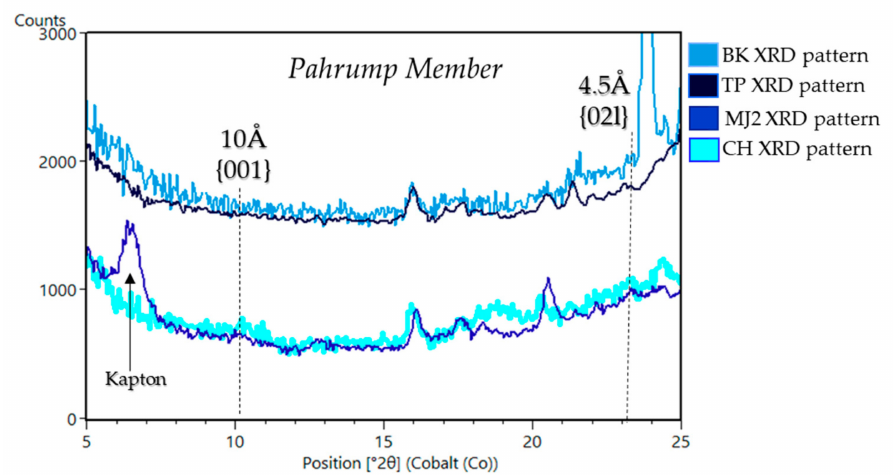
Figure 12. CheMin XRD patterns from 5 ◦ to 25 ◦ 2 θ of samples from the Pahrump Hills member. The basal d-spacing peaks of the d(001) of 10 Å and d(02l) of 4.5 Å are denoted by dashed black lines. Broad 10 Å peaks are seen in the CH and MJ2 patterns, in contrast to the lack of d(001) and d(02l) peaks in the TP and BK patterns that do not contain phyllosilicates. Kapton peak artifact is part of the sample cell and is not in the rock powders.